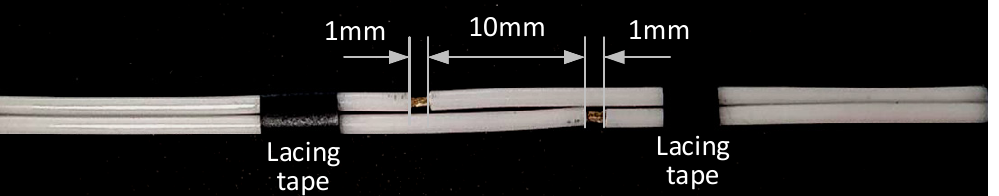
Figure 3. ETFE-insulated pair of wire samples used to analyze the inception of the partial dis- charges.